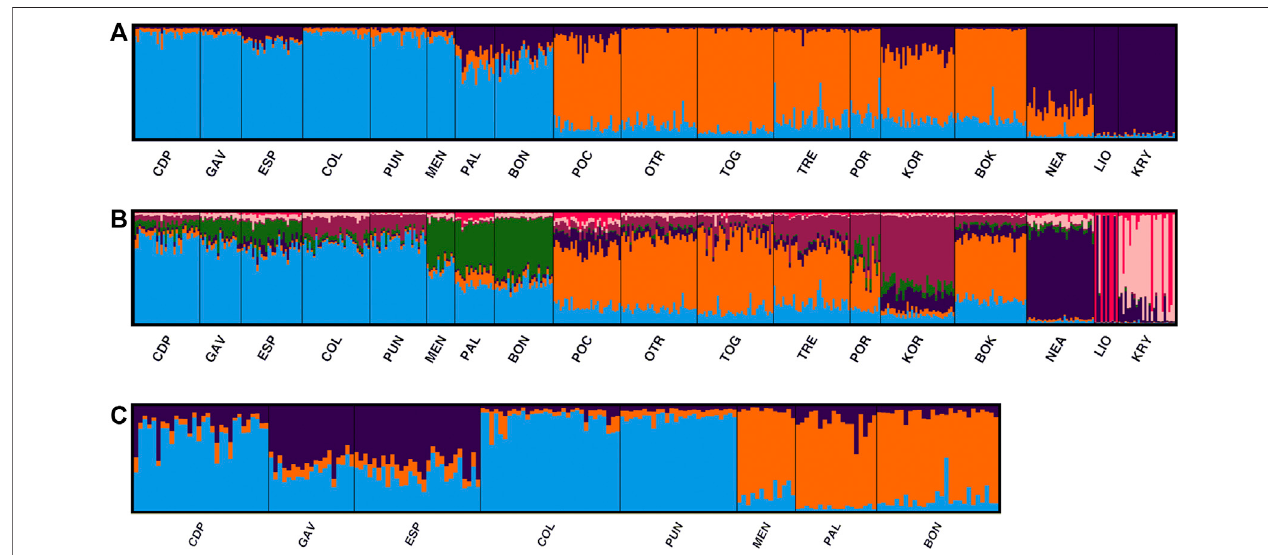
FIGURE4| STRUCTUREresultsselectedbyClumpakforthe18analysedpopulationsof C.caespitosa for (A) K =3and (B) K =7. (C) Resultsforonlythewestern Mediterranean populations for K = 3.